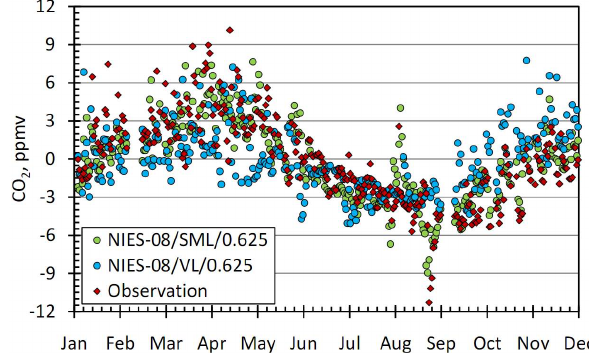
Fig. 14. Daily seasonal cycle of CO 2 over Hateruma Island, Japan (24.05 ◦ N, 123.81 ◦ E) for 2008